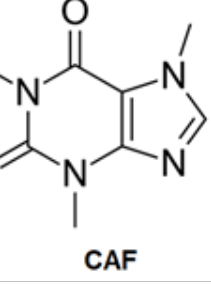
Figure 2. Chemical structures of the two markers of pharmaceuticals and personal care products PPCPs studied: caffeine (CAF) and acetaminophen (ACF).